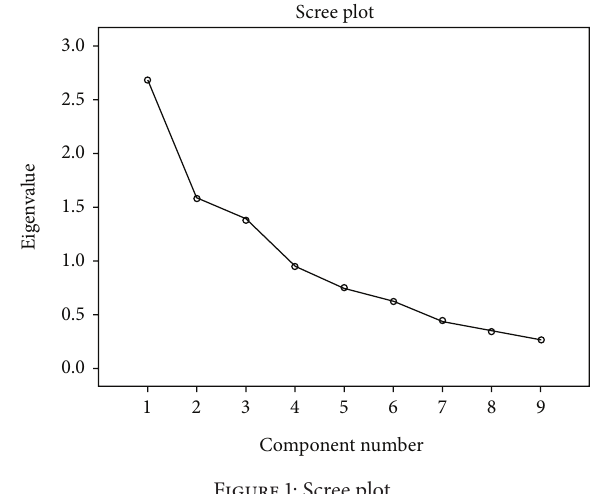
Figure 1: Scree plot.